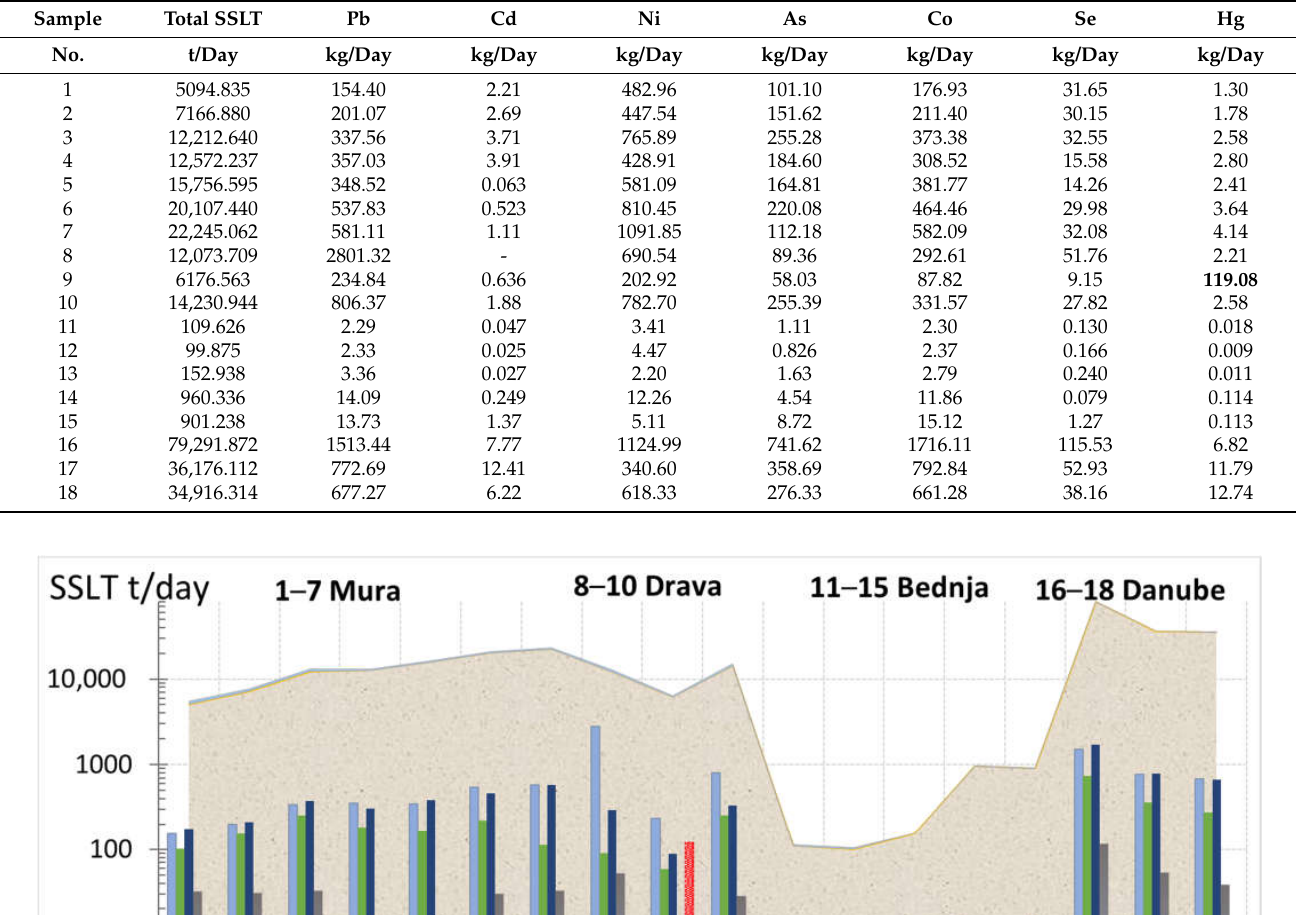
Table 4. The total amount of metals (kg/day) in daily SSLT.